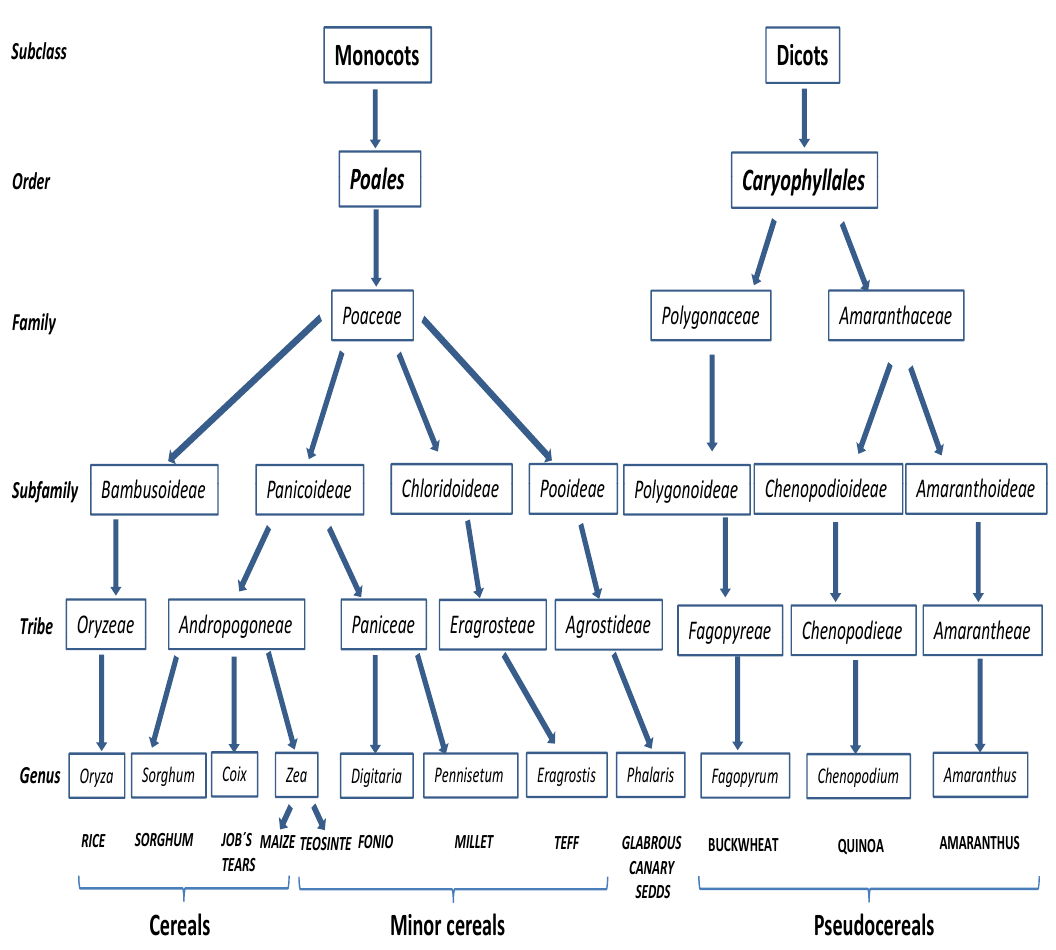
Figure 2. Taxonomic relation of known non-toxic cereals, minor cereals and pseudocereals in the context of celiac